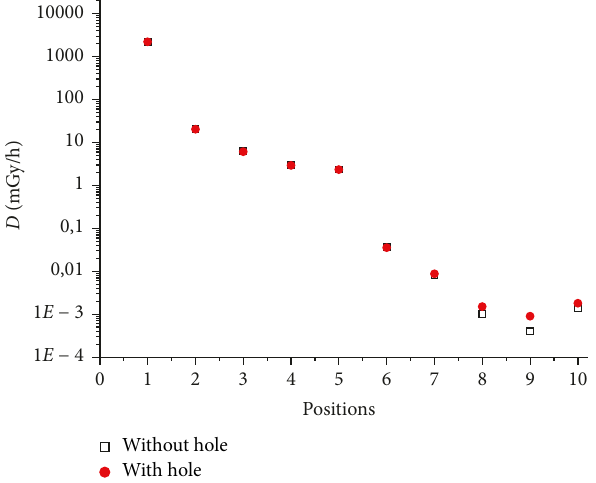
Without hole With Figure 6: Dose rate distribution as function of positions of evalu- ated points obtained with MCNPX code with ∗ F 5 tally.